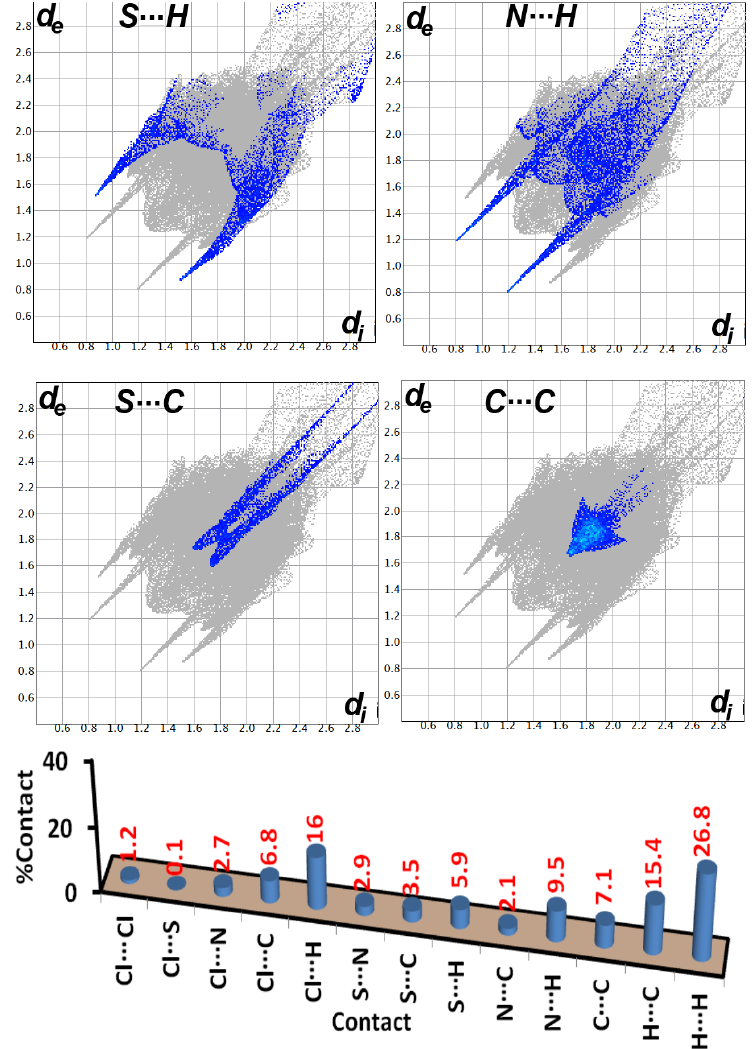
Figure 7. Hirshfeld surfaces of 4 .